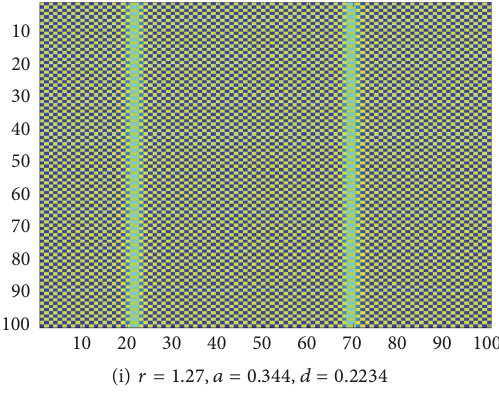
Figure 3: Turing